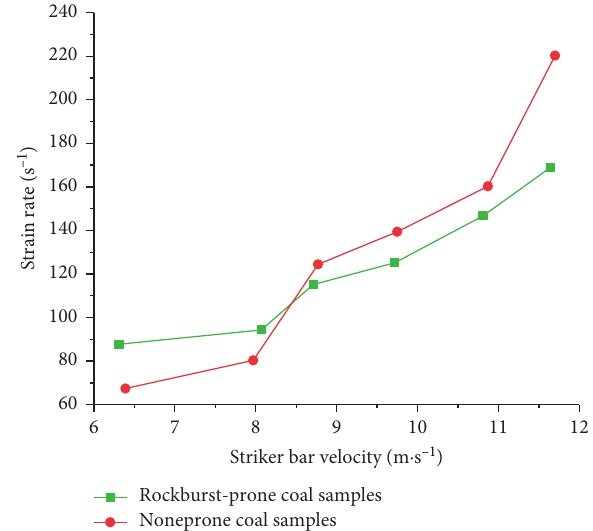
Figure 3: Relationship between impact velocity and strain